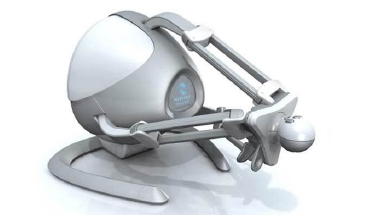
Figure 4. Novint Falcon haptic device used in interactive visuo-haptic